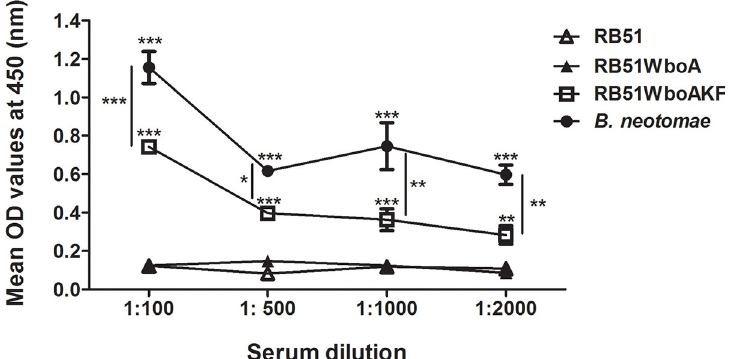
Fig 4. ELISA detection of O-polysaccharide expression on the cell surface of strain RB51WboAKF. RB51, RB51WboA, RB51WboAKF and B . neotomae whole cells (10 8 CFU/well) were reacted with specific dilutions of anti- B . neotomae LPS antibody. The results are shown as mean ± standard deviation (n = 2) of the optical density (OD) at 450 nm of the color developed. Asterisks indicate statistically significant differences from strain RB51. � , P < 0.05; �� , P < 0.01; ��� , P < 0.001. OD, optical